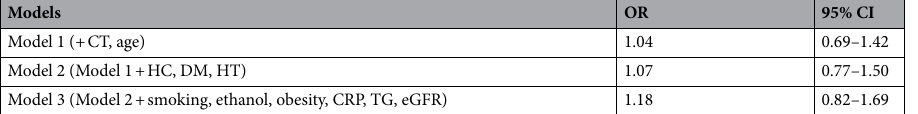
Table 4. The OR (95%CI) of aortic calcification presence for ISFs (n = 979). OR, odds ratio; CI, confidence interval; CT, computerized tomography; HT, hypertension; DM, diabetes; HC, hypercholesterolemia; eGFR, estimated glomerular filtration rate; TG, triglycerides; CRP, C-reactive protein; ISFs, isoflavones. ISFs = creatine-adjusted urinary levels of daidzein + genistein, and ISFs were log-transformed.